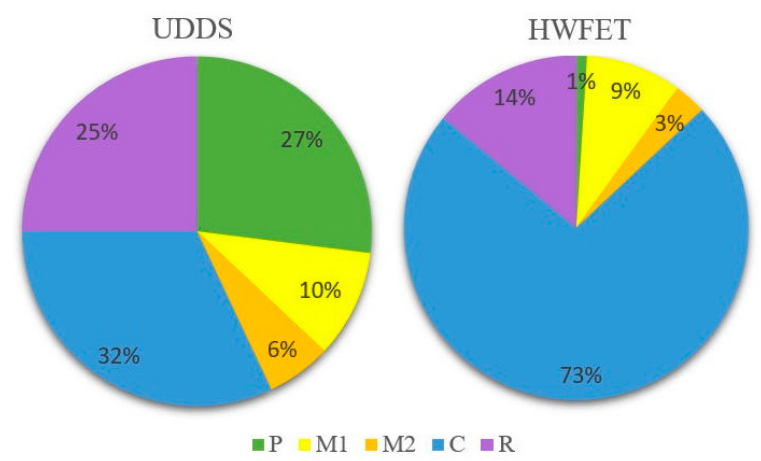
Figure 17. Comparison of operation mode selection between UDDS and HWFET.